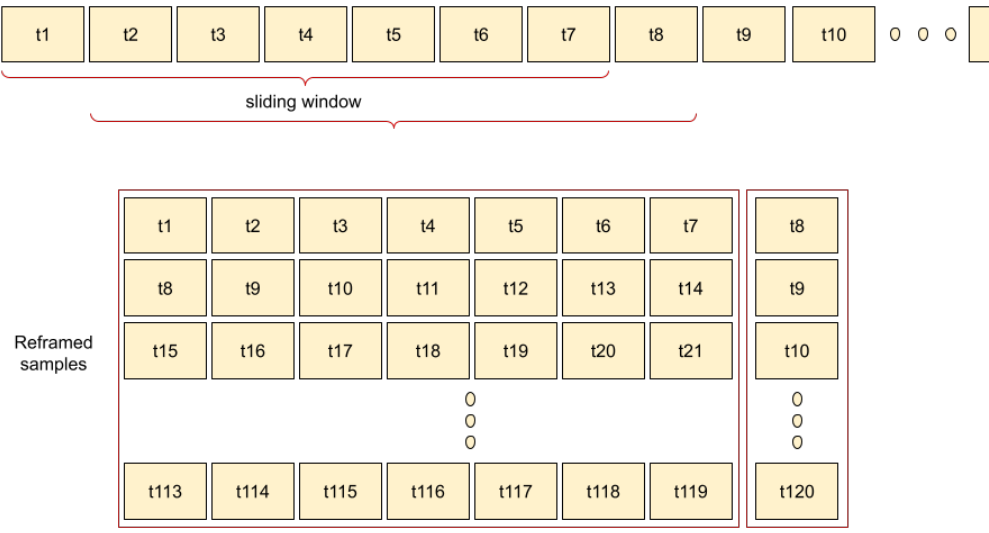
Figure 10. Time series conversion into supervised learning data, for a lookback value of